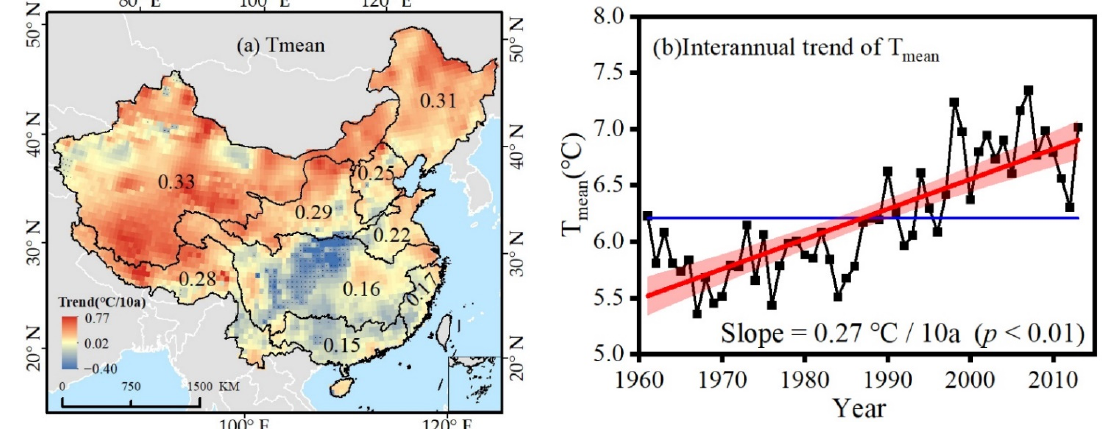
Figure 1. Spatial distribution of the T mean trend in mainland China ( a ) and interannual trend of T mean in mainland China ( b ) from 1961 to 2013. (The letters in figure ( a ): A—Songhua and Liaohe River basin, B—Haihe River basin, C—Huaihe River basin, D—Yellow River basin, E—Yangtze River basin, F—Pearl River basin, G—Southeast basin, H—Southwest basin, I—Continental basin. The